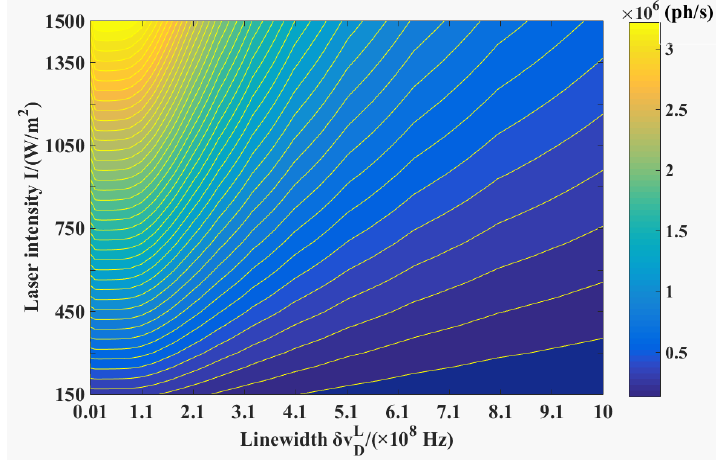
Figure 9. Average spontaneous emission rates for laser linewidth from 3 to 10 3 MHz and laser intensity I = 150 − 1500 W/m 2 .